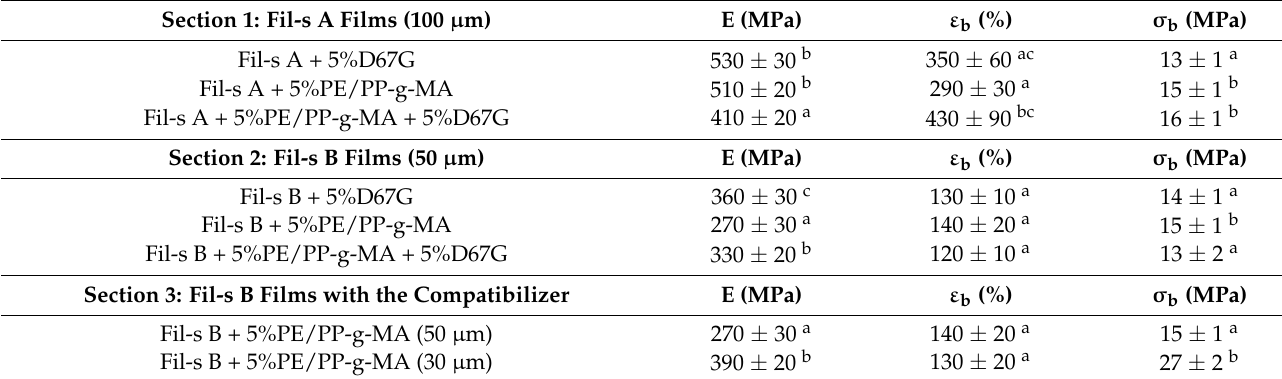
Table 7. Main tensile mechanical properties (E, Young’s modulus; ε b strain at break; σ b stress at break) of Fil-s A and Fil-s B-based films. Regarding the films in each section, if the data in the same column are marked with different superscript letters, it means that a significant difference ( p < 0.05) exists between the